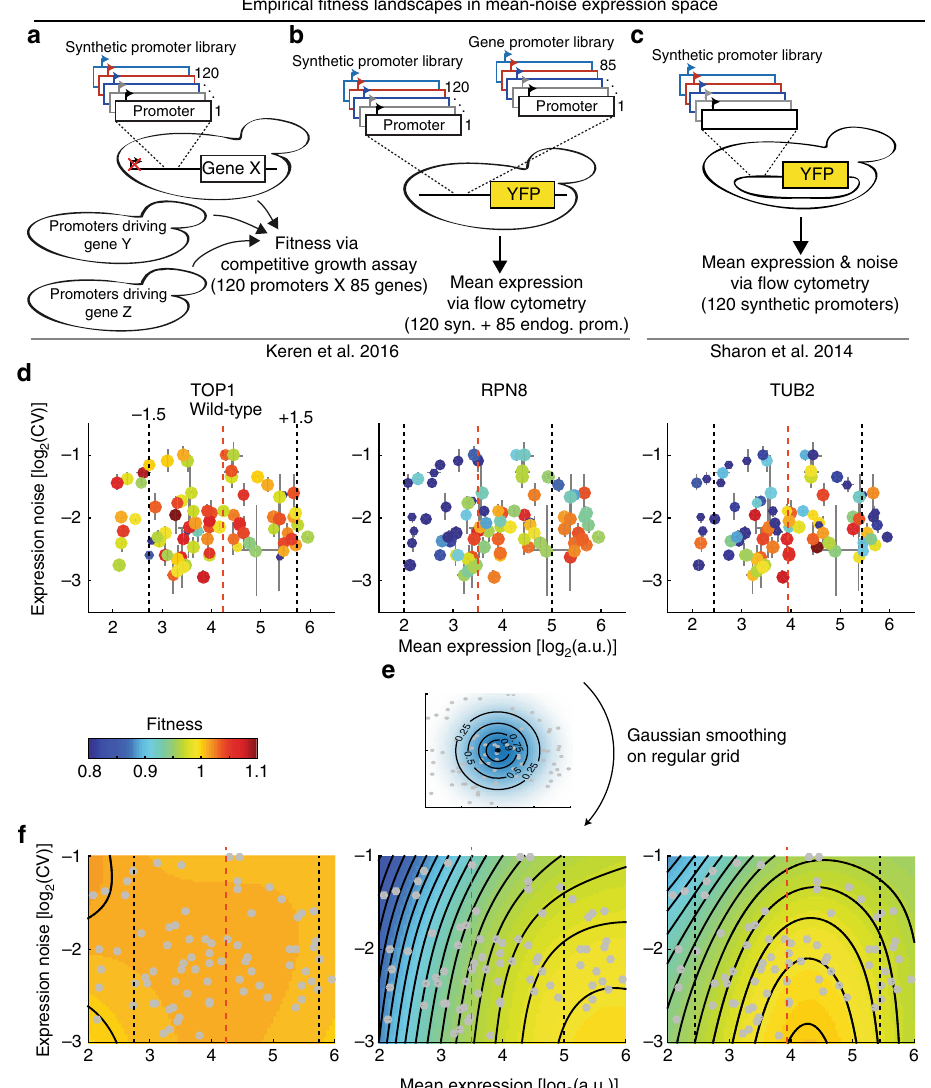
Fig. 2 Mean-noise- fi tness landscapes reveal gene-speci fi c responses to expression deviations. a Keren, et al. 24 constructed yeast strains where in each strain one of a panel of genes (X, Y, Z, … ) is driven by one of a panel of 120 synthetic promoters. All constructed strains were pooled and their fi tness was measured in competitive growth experiments. b Relative mean expression strength of the synthetic promoters as well as the endogenous promoters of all investigated genes was measured by cloning each promoter in front of YFP in the HIS3 locus and assaying the resulting strains individually by fl ow cytometry 24 . c Sharon, et al. 38 cloned synthetic promoters in front of YFP on a plasmid. Fluorescent activated cell sorting in combination with deep sequencing was used to infer mean expression and noise of individual promoters. d Fitness of synthetic promoter-gene strains plotted in mean — noise expression space for three example genes. Each panel shows the fi tness (growth rate relative to wild-type, indicated by colour) of 79 yeast strains, in each of which a particular synthetic promoter drives the indicated gene, as a function of mean expression and noise of the synthetic promoters. Size of circles is inversely proportional to the measurement error of fi tness. Error bars in horizontal and vertical directions indicate measurement error (s.e.m.) in mean and noise direction, respectively. Red vertical line shows estimated wild-type expression of the gene, dashed vertical lines mark region ± 1.5-fold from wild-type expression. Source data are provided as a Source Data fi le. e , Mean-noise- fi tness landscapes were reconstructed using Gaussian smoothing on a regular grid, with fi tness at each grid point as the weighted sum over the fi tness of all strains. Weighting depends on distance to grid point (shown) and measurement errors in all three dimensions (see Methods). f Smoothed mean-noise- fi tness landscapes of the three genes shown in panel d . Surface colour indicates fi tness. Contour lines are spaced in increments of 0.01 fi tness units. Strains (grey points), wild-type expression (red vertical line) and± 1.5-fold around wild-type expression (grey vertical lines) are indicated. CV coef fi cient of variation, a.u. arbitrary The reconstructed mean-noise fi tness landscapes reveal that for TOP1 there is essentially no systematic effect of mean expression or expression noise on fi tness (Fig. 2f, see Fig. 3 for all landscapes). The fi tness landscape of RPN8 reveals coupled